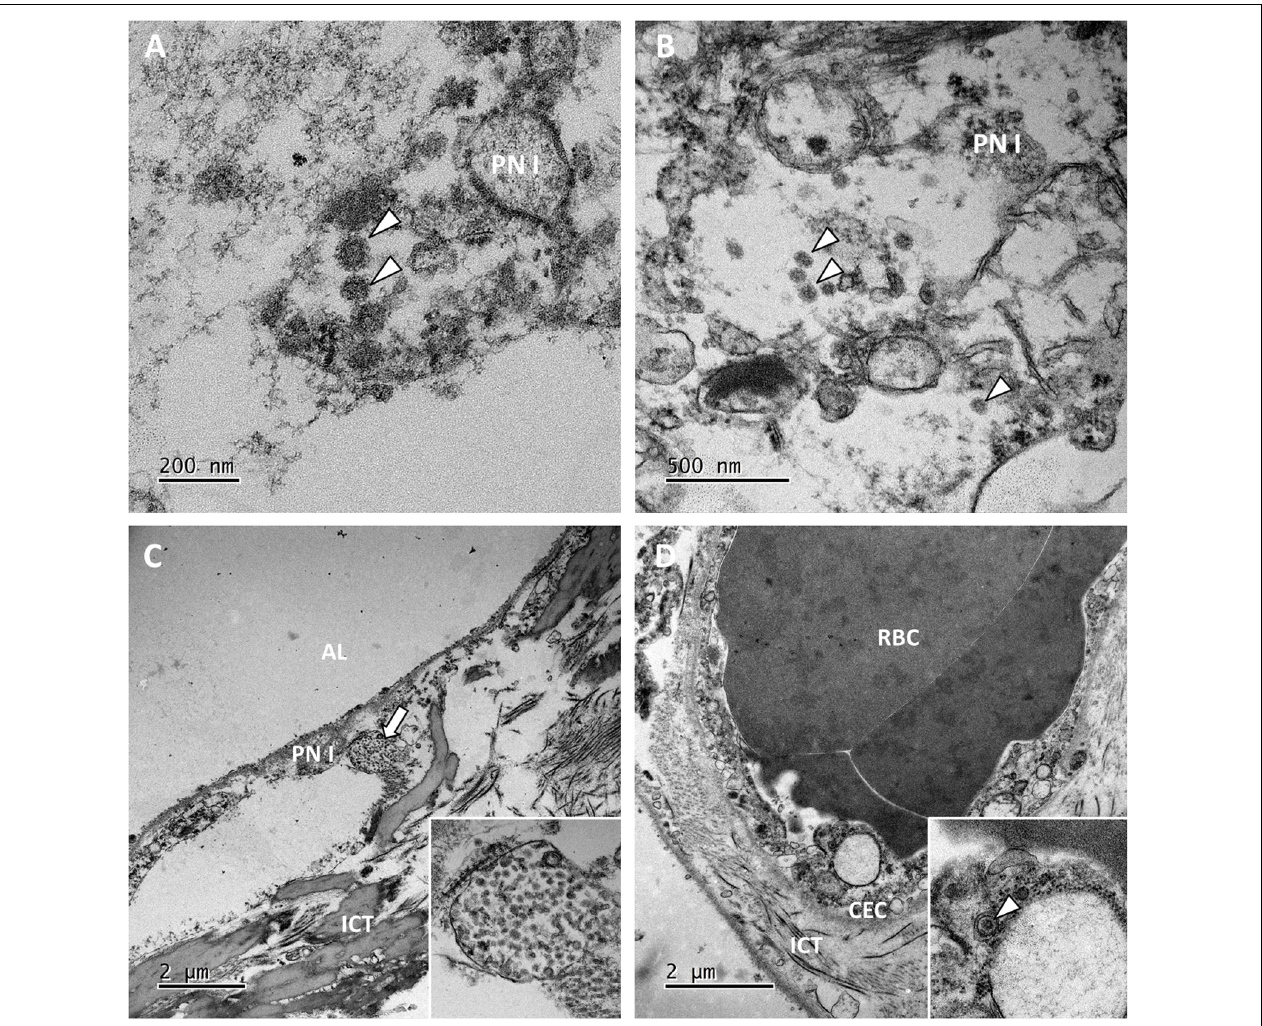
FIGURE 2 | Ultrastructural findings in the lungs. (A,B) Viral particles harboring the typical crown of spikes projection (white arrowheads) were present in the cytosol of lytic type I pneumocytes (PN I) in patients 11 and 12. (C) In the pneumocytes from patient 12, viral particles also accumulated in large vacuoles (the white arrow; see the inset for a higher magnification image). AL, alveolar lumen; ICT, interstitial connective tissue. (D) Lung capillaries were often obstructed with red blood cells (RBCs). In patient 10, capillary endothelial cells (CECs) occasionally contained a few isolated viral particles in small vesicles (the white arrowhead in the